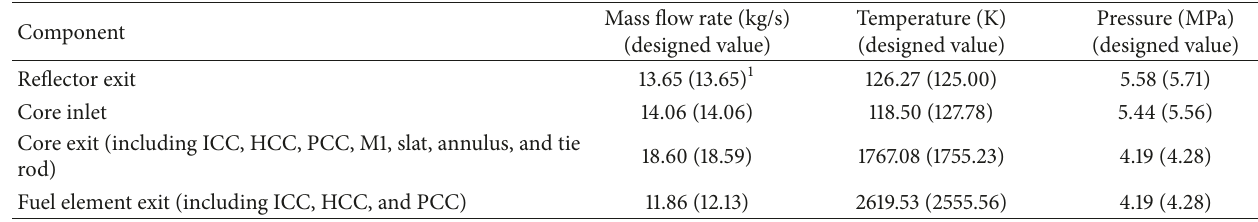
Table 8: Sample tuned parameters.